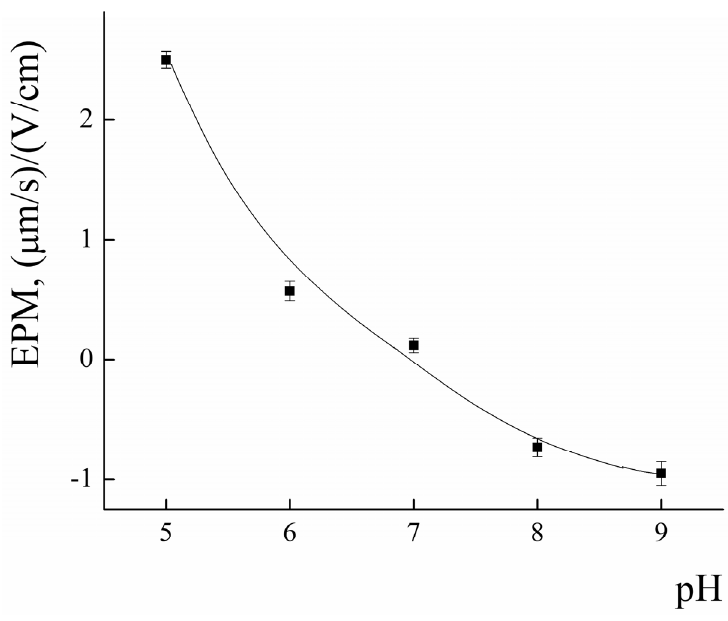
Figure 7. The pH dependence of EPM for PLAMs–us; 25 °C.